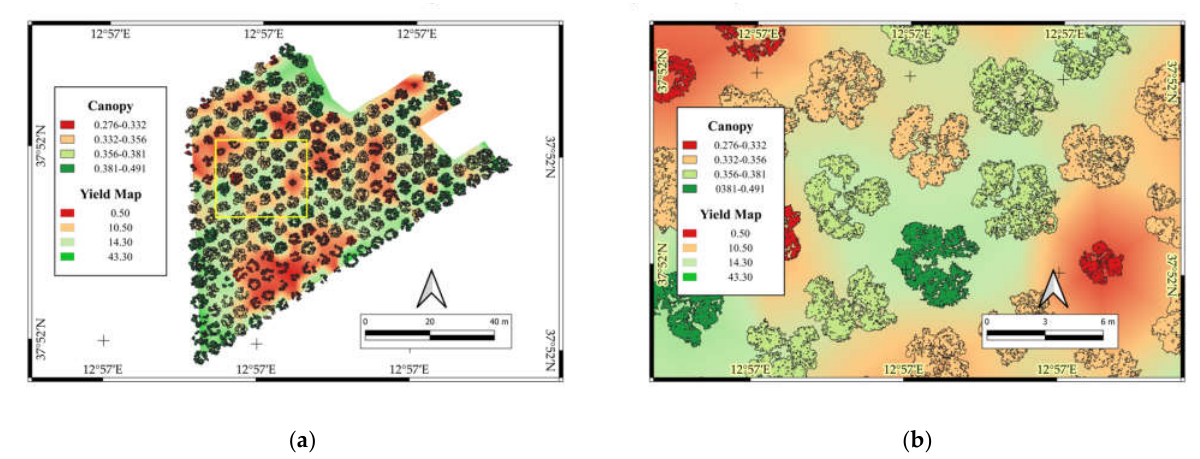
also showing a certain variability in olive yield.